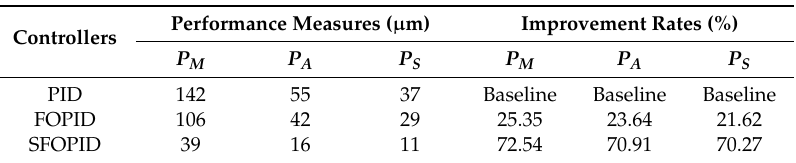
Table 1. Performance measures and improvement rates for the sinusoidal reference tracking of various VCM control systems in Case 1.